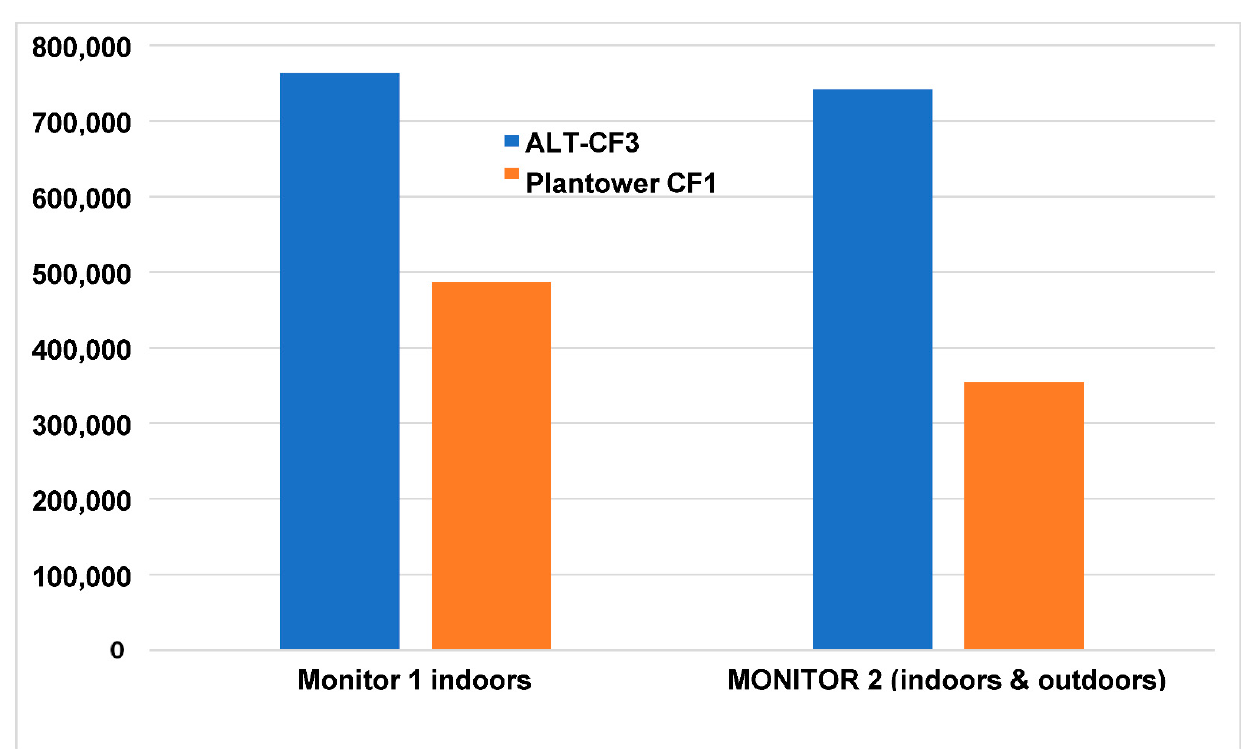
Applying the precision cutoff of 0.2 for the Plantower CF1 measurements resulted in an additional loss of 25% of the remaining data for monitor 1 and 45–50% of the remaining data for monitor 2. Overall, the loss of data using the Plantower CF1 algorithm amounted to 277,488 (36%) measurements for monitor 1 and 387,991 (52%) of all measurements for monitor 2 (Figure 3).